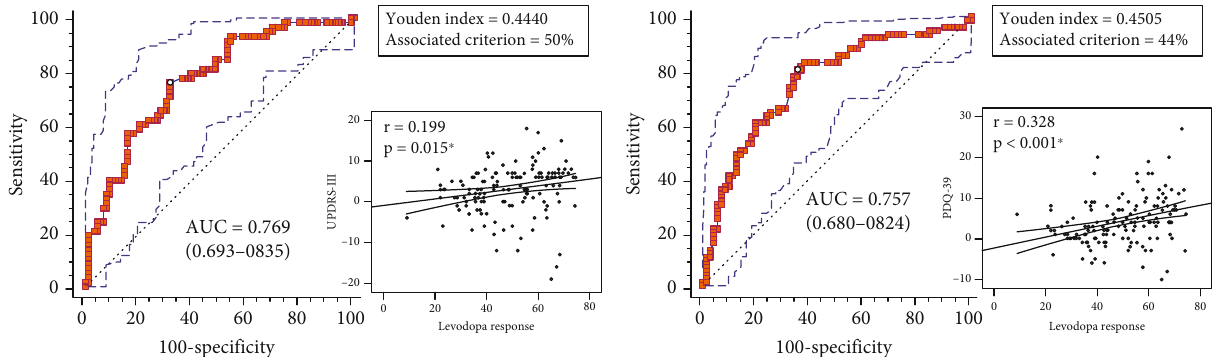
Figure 1: The receiver operating characteristic curves and scatter plots between TLR and postoperative STN-DBS bene fi ts in the training set. (a) The combination of TLR and UPDRS-III improvement. (b) The combination of TLR and PDQ-39 improvement. Signi fi cant correlations are highlighted in bold and marked by ∗